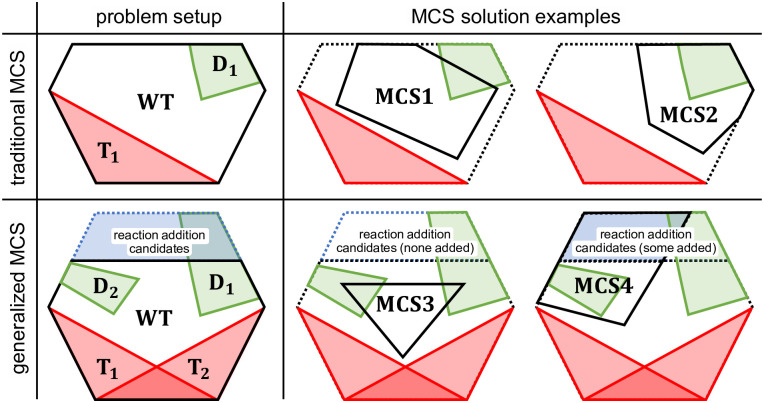
Exemplary illustration of metabolic solution spaces (solid black lines) of wild type and mutant strains for traditional and extended/generalized MCS computation.Red areas: target regions, green areas: desired regions, blue area: flux states accessible through the addition of reactions.